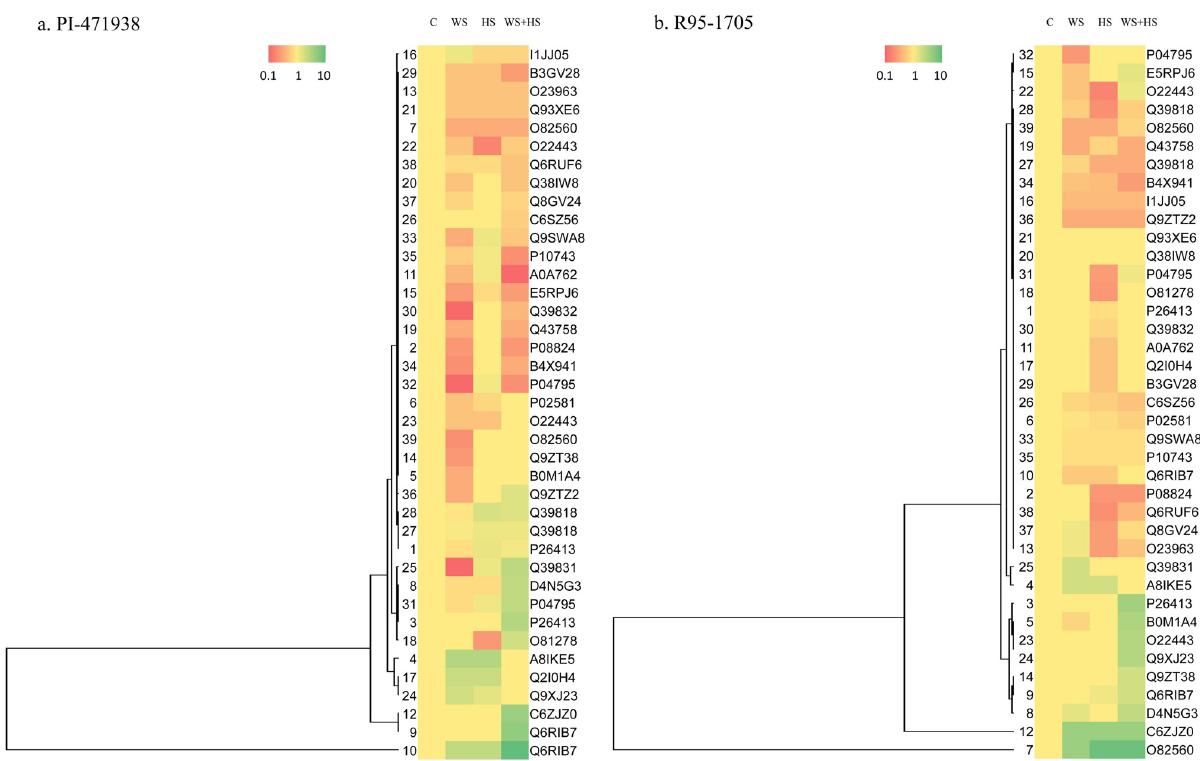
Fig 6. Relative abundance of stress responsive proteins (SRPs) in a) PI-471938 and b) R95-1705 cultivars as depicted in hierarchical cluster. The protein abundance ratios were used for cluster analysis by a hierarchical clustering method. Columns (from left to right): Control(C), Water Stress (WS), Heat Stress (HS), and Combination of Water and Heat Stress (WS+HS).